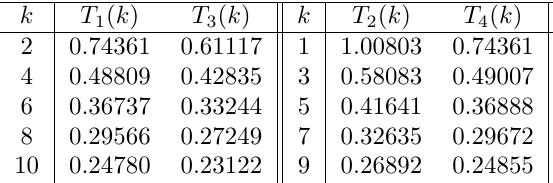
Table 1. Effect of nullity on the energies of the non-singular trees T 1 ( k ) and T 3 ( k ) for k = 2 , 4 , . . . , 10 , and of the non- singular trees T 2 ( k ) and T 4 ( k ) for k = 1 , 3 , . . . , 9 , computed according to Theorem